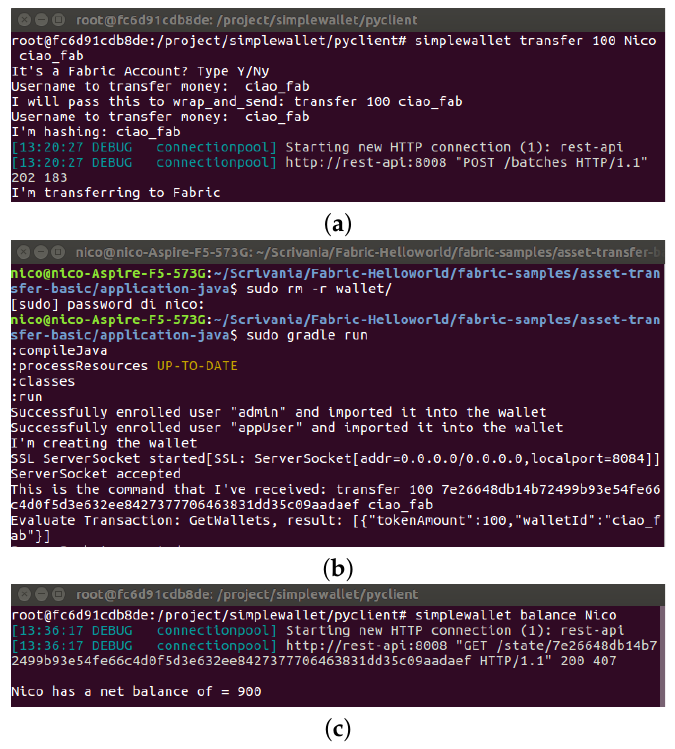
Figure 9. Interoperability unit test: ( a ) Transferring from a Sawtooth wallet to a Fabric one, ( b ) Re- ceiving the transfer request on Fabric, ( c ) Checking the origin wallet after the